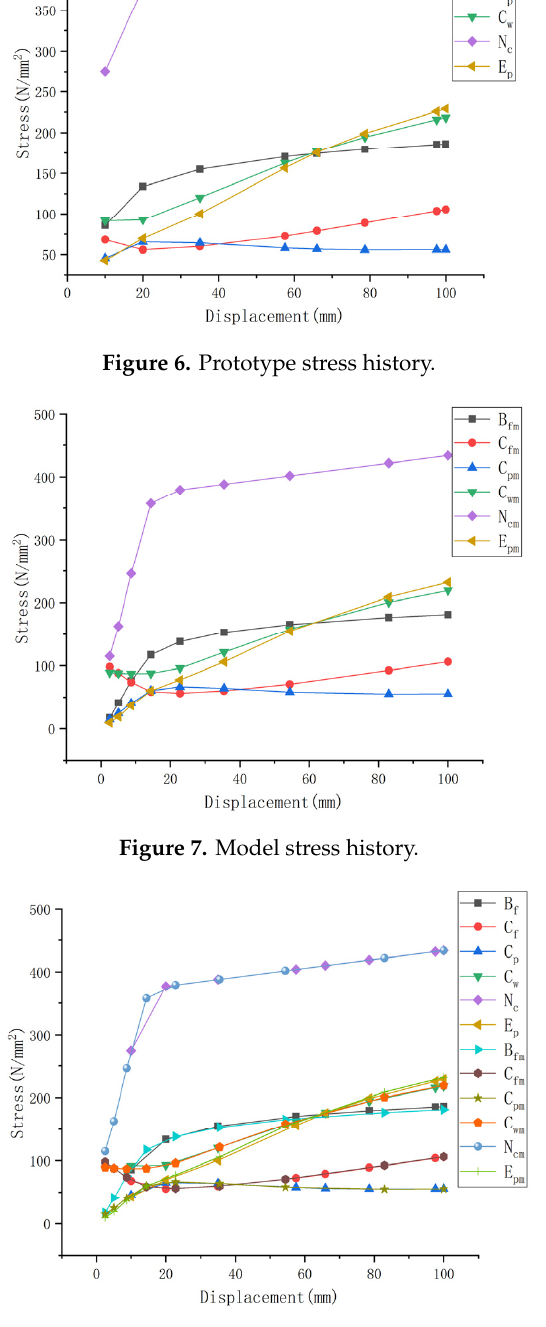
Figure 8. Comparison of the stress history of the prototype and the model.